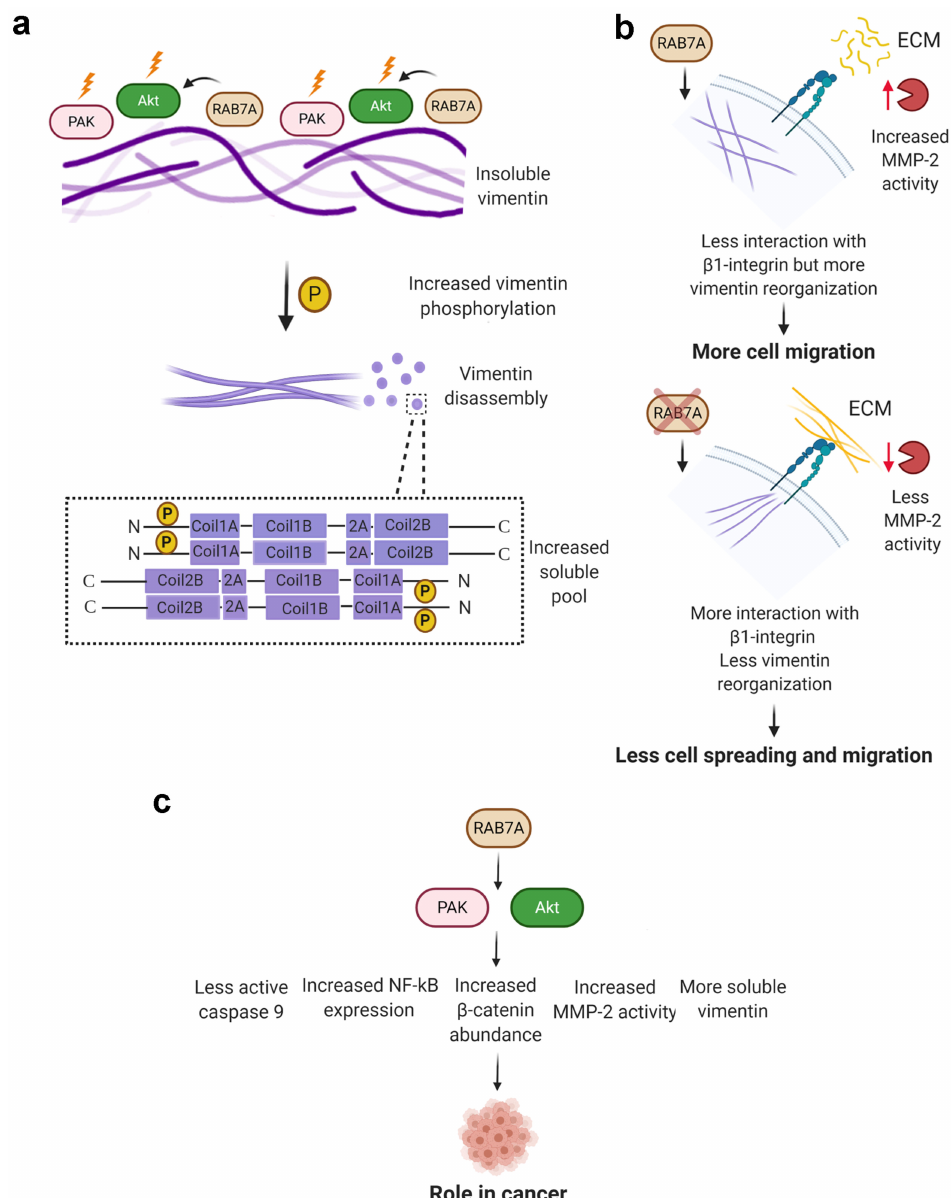
Figure 8. RAB7A regulation of vimentin assembly and of several AKT and PAK effectors. ( a ) RAB7A interacts with vimentin and activates AKT and PAK which in turn phosphorylate vimentin head domain. This increased phosphorylation leads to the disassembly of vimentin filaments in soluble tetramers made of two antiparallel dimers. ( b ) expression of RAB7A leads to vimentin filaments reorganization, increased MMP2 activity, and faster cell migration (top), whereas depletion of RAB7A determines alteration of vimentin filaments reorganization, reduced MMP2 activity, and slower cell migration (bottom). ( c ) schematic overview of RAB7A regulation on AKT and PAK kinases and their downstream effectors in cell migration, apoptosis, and cancer. Created with Biorender.com (accessed on 1 April